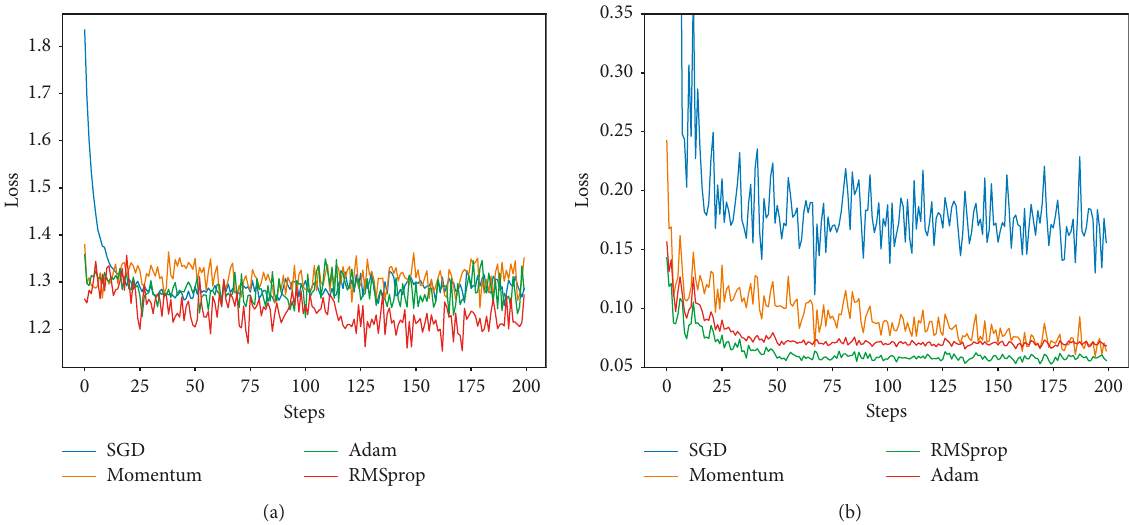
Figure 9: Performance comparison of the two models. (a) Loss of training with original data after PCA. (b) Loss of training with complexity degree after PCA.